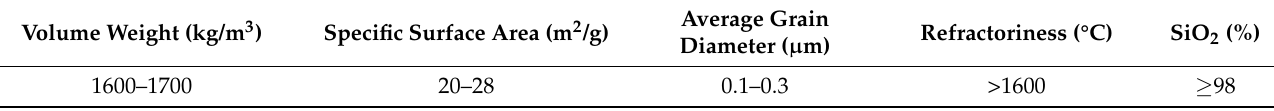
Table 3. Physical properties of silica fume.